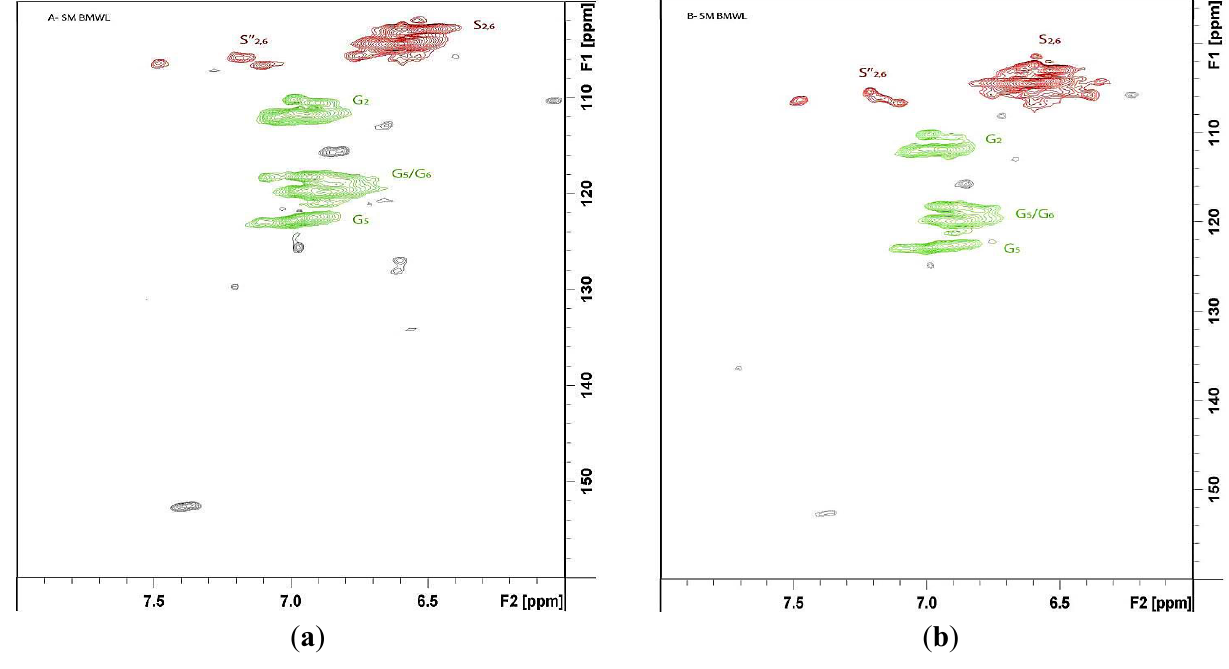
Figure 3. HSQC spectra of the aromatic region of SM MWL: ( a ) MWL_SM_AW and ( b ) MWL_ESM_DCM depicting syringyl and guaiacyl units corresponding to substructures in Figure